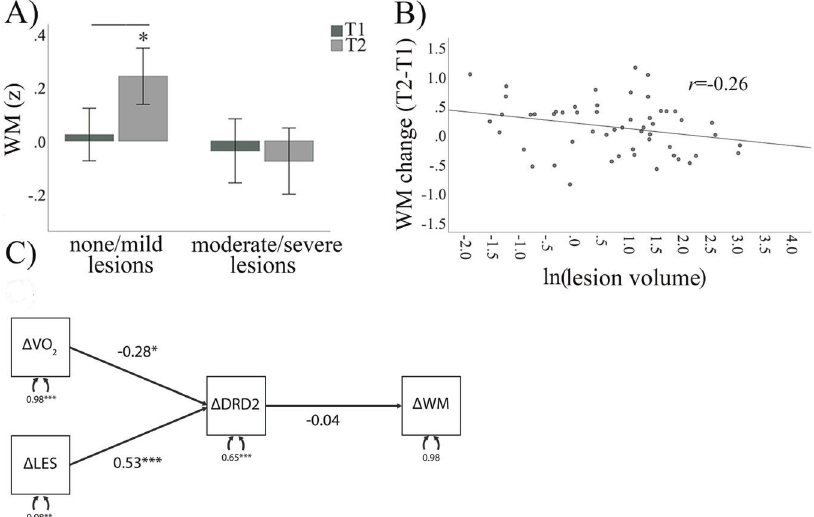
Fig. 3 Lesion severity and working memory. Working memory gains were restricted to the group of individuals with mild lesion severity A , with a trend for a linear association B . A path analysis showed association between change in VO 2 peak and lesion volume in relation to putamen DRD2 change C . No links were found between putamen DRD2 change and working memory change. Working memory is expressed as a Z-score. Each value is adjusted for age, gender, and education. * p < 0.05. WM working memory, LES lesions, DRD2 dopamine D2-receptor, T1 timepoint 1 - baseline, T2 timepoint 2 - follow-up, Δ change.